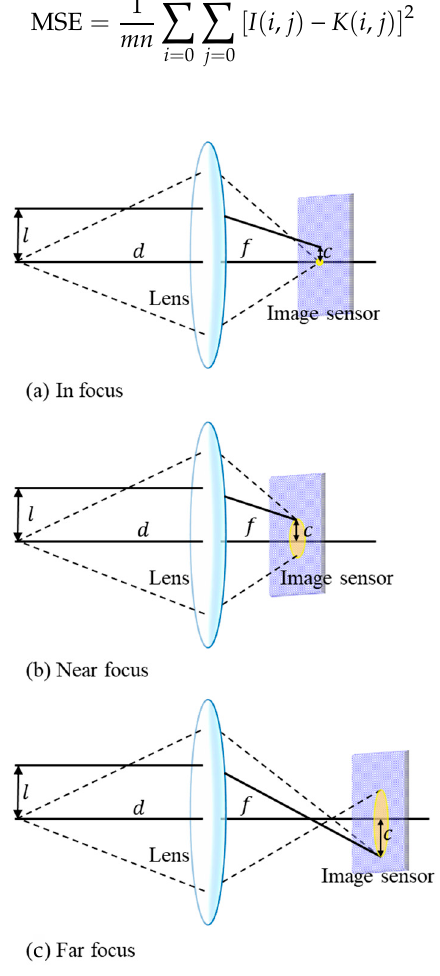
Figure 12. Lens focuses incoming light on the IS: ( a ) in focus; ( b ) near focus; ( c ) far focus [17].